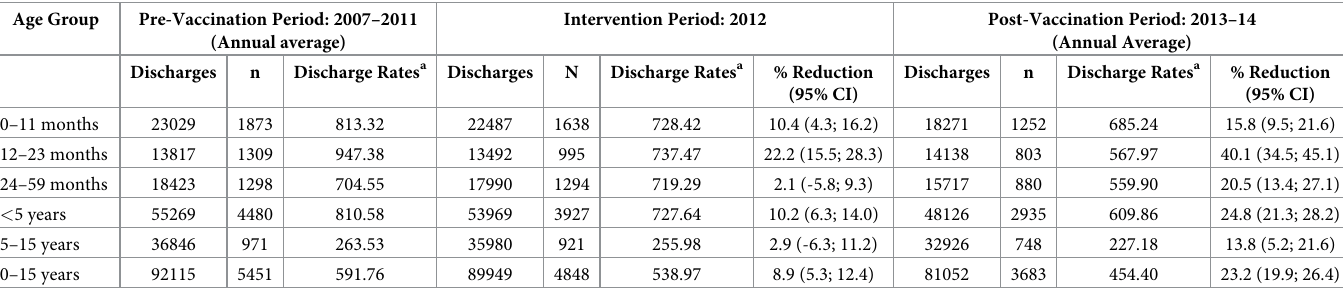
Table 1. Consolidated pneumonia discharge rates by age. PCV13 vaccination